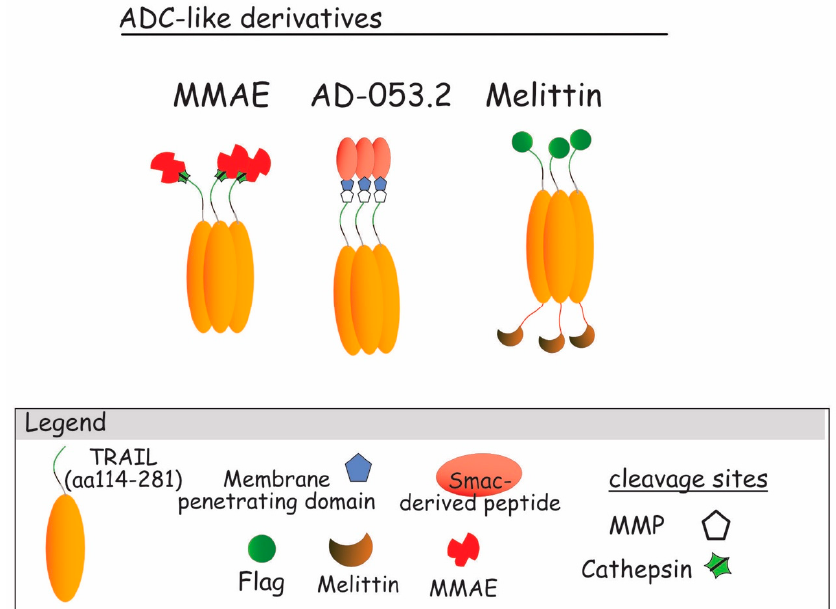
Figure 10. TRAIL ADC-like derivatives. From the left to the right : ADC-like TRAIL build up with Smac-derived peptide (AD-053.2) an intracellular pro-apoptotic agent [225]; Melittin ADC-like, an antibacterial highly cytotoxic harbored on trimeric TRAIL and linked with FLAG [226,227]; MMAE–TRAIL, TRAIL trimeric molecule linked to the monomethyl auristatin E, an antimitotic agent [222–224].